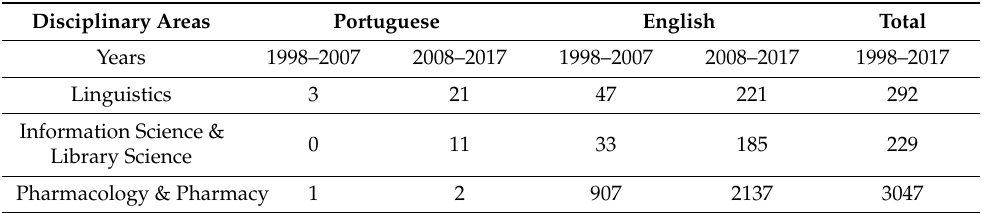
Table 1. Web of Science indexed research articles